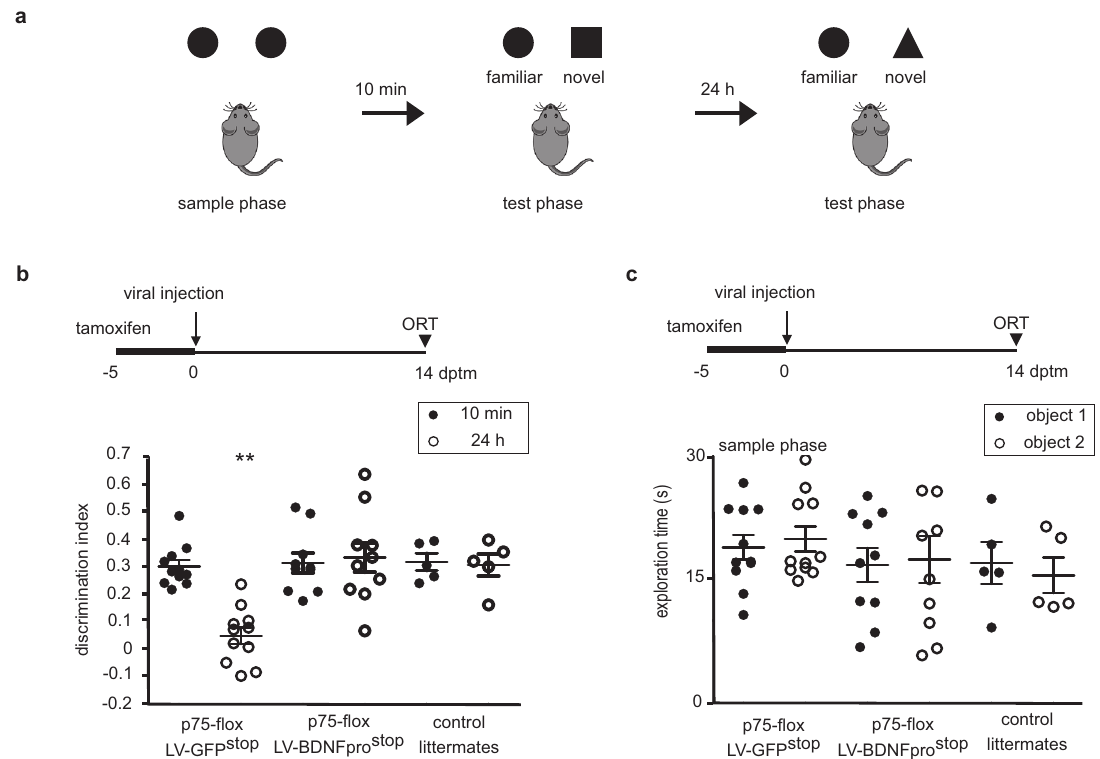
Fig. 8 BDNFpro restores memory retention in p75- fl ox mice. a Schematic diagram depicting the behavioral paradigm used for ORT. Mice were subjected to familiarization (sample phase) with two identical objects (circles). A test phase in which one familiar object (circle) is substituted with a novel one was performed after 10 min (square) and 24 h (triangle). b Schematic diagram depicting the experimental paradigm. p75- fl ox mice and control littermates treated with tamoxifen ( − 5 to 0) and injected with LV-GFP stop or LV-BDNFpro stop the last day of tamoxifen treatment (0 dptm) were subjected to ORT (14 dptm). Discrimination index is plotted against time interval between sample phase and test phases. ** p < 0.01 (post hoc Holm – Sidak) ( n = 11 mice for p75- fl ox/LV-GFP stop ; n = 10 mice for p75- fl ox/LV-BDNFpro stop ; n = 5 mice for control littermates). c Schematic diagram depicting the experimental paradigm as in ( b ). The dot plot shows mean exploration time of the familiar object and the novel object in the sample phase ( n = 11 mice for p75- fl ox/LV- GFP stop ; n = 10 mice for p75- fl ox/LV-BDNFpro stop ; n = 5 mice for control littermates). Data are presented as mean ±